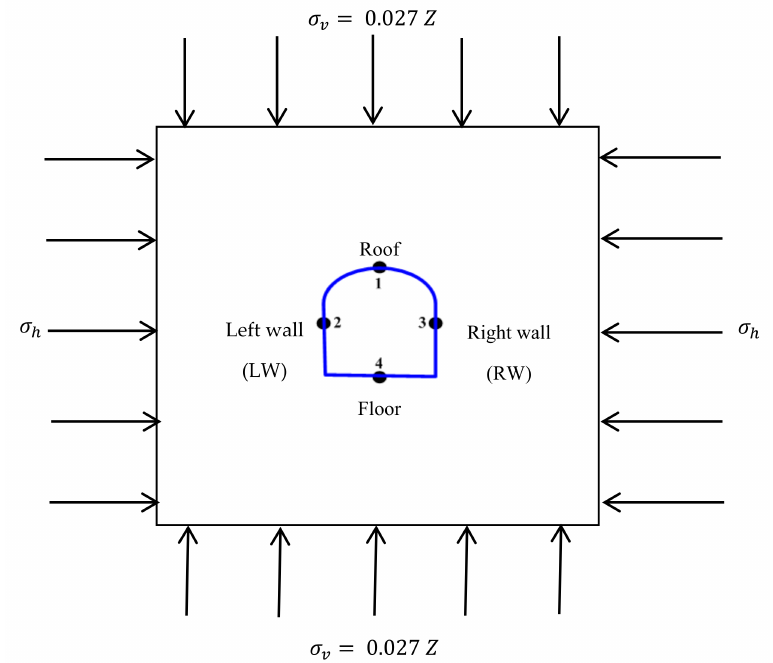
Figure 1. In situ horizontal and vertical stresses imposed on rock mass before creating tunnel